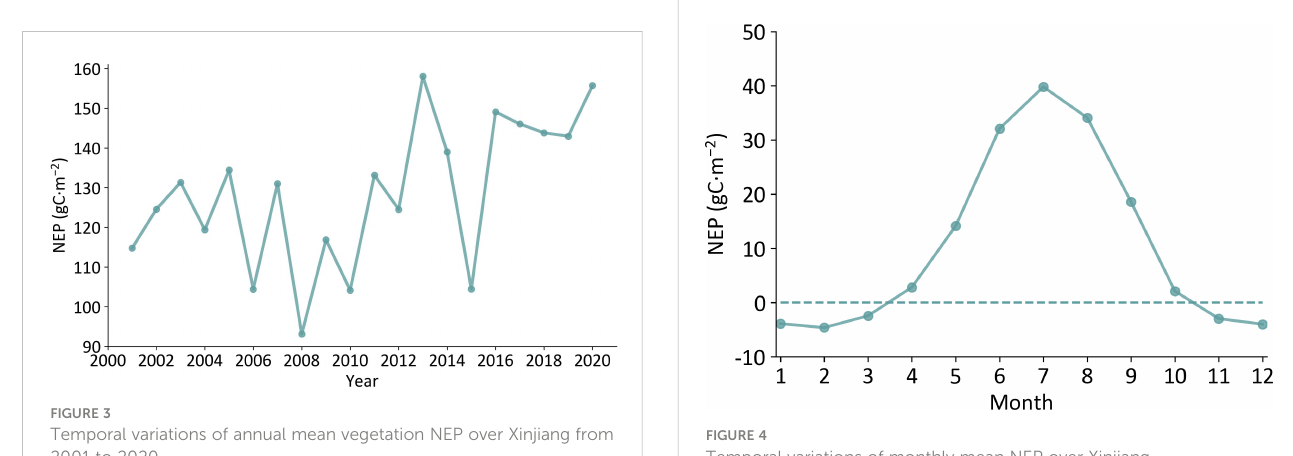
FIGURE 3 Temporal variations of annual mean vegetation NEP over Xinjiang from 2001 to 2020.